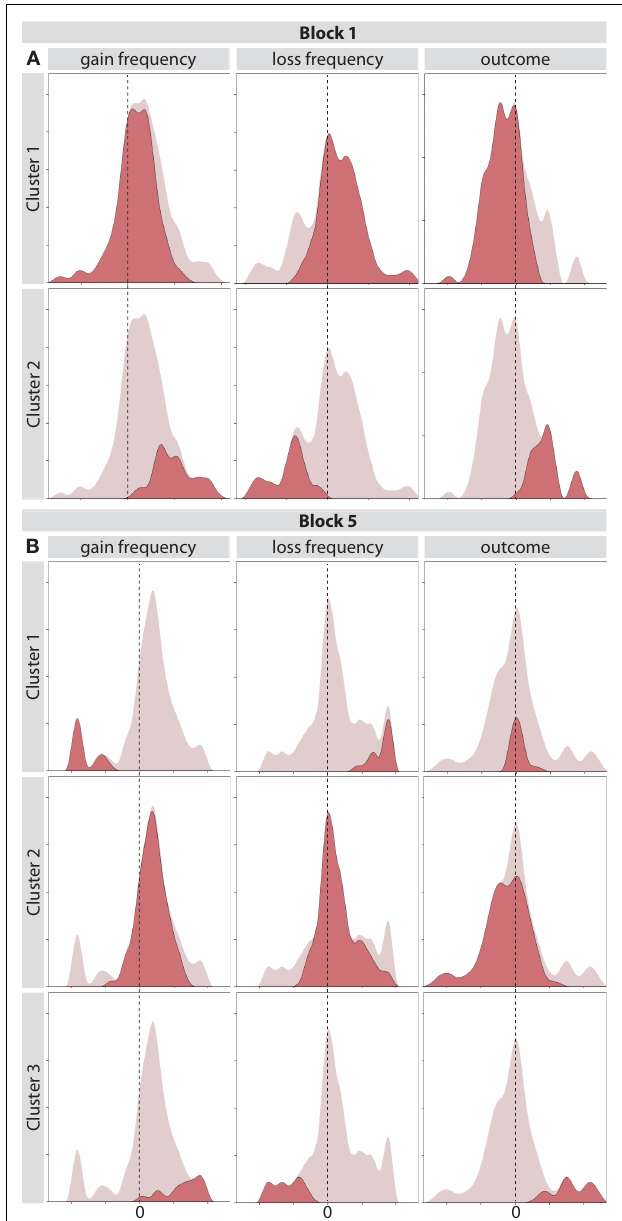
FIGURE 4 | (A) Distribution of weight values for clusters obtained with a two-step clustering algorithm on block one of the IGT. Columns correspond to the three task features and rows correspond to different clusters. (B) Distribution of weight values for clusters obtained with a two-step clustering algorithm on the last block of the